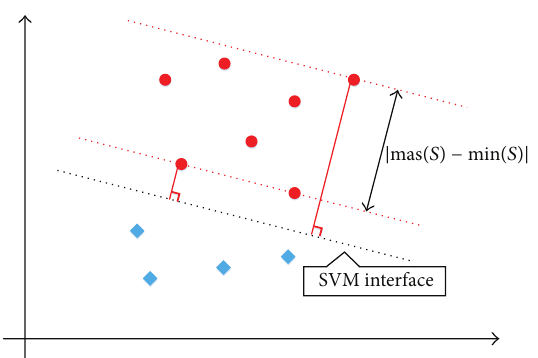
Figure 5: Density-based, parameter-weights optimization on the distribution of a heterogeneous dataset for C-SVM.